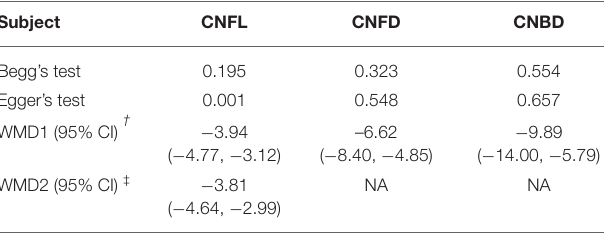
TABLE 2 | Publication bias measured by Begg’s and Egger’s tests, WMD (95% CI) recalculated with trim and fill